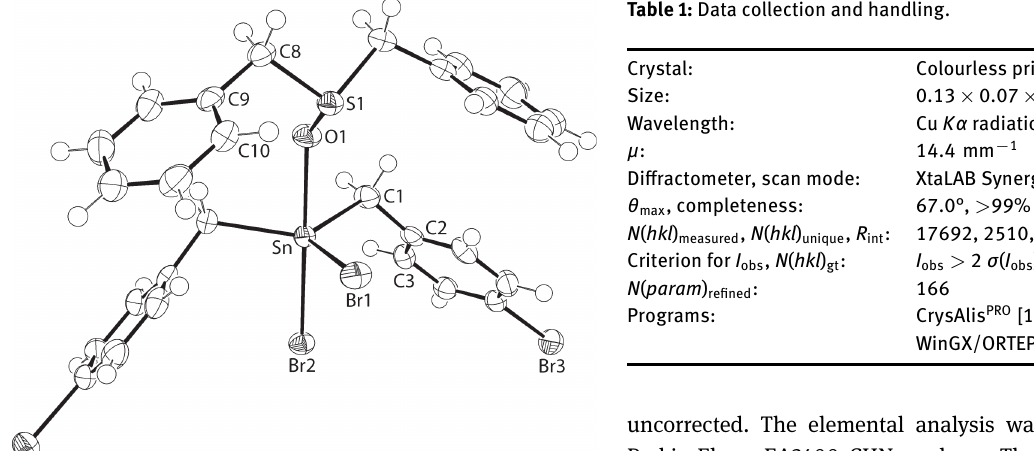
Table 1: Data collection and